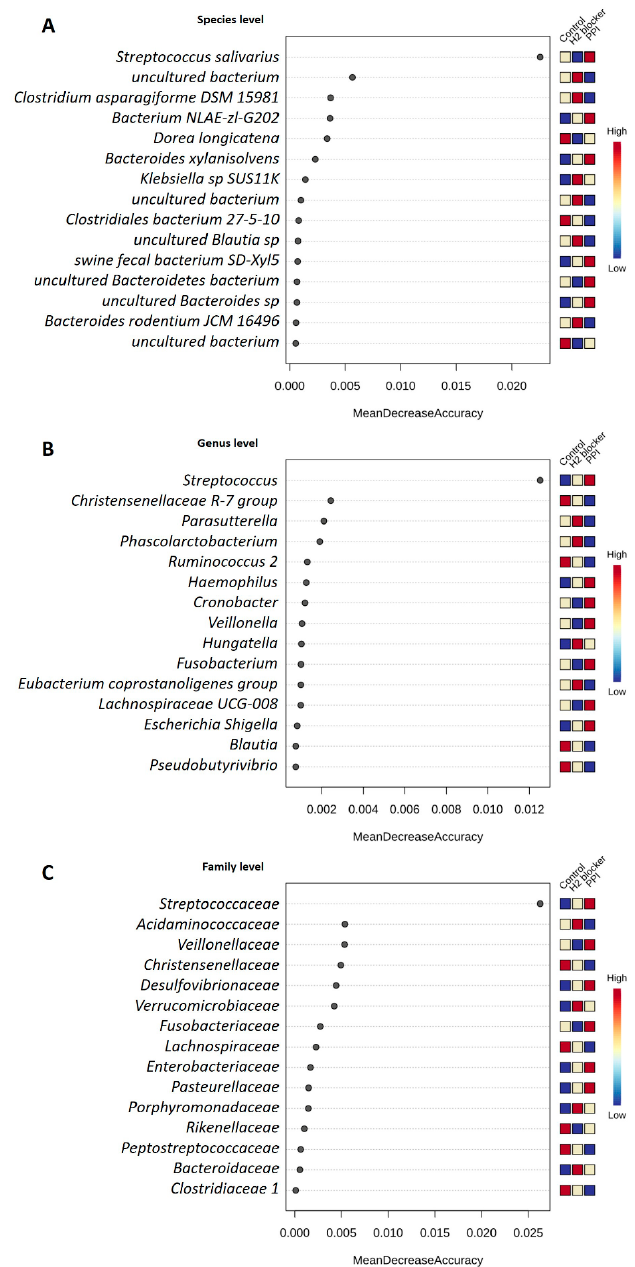
Figure 5. Determination of bacteria-specificity for discrimination across H 2 -blocker users, proton pump inhibitor users, and controls in hemodialysis patients. The anti-acid drugs discriminatory taxa were determined by applying random forest analysis using the ( A ) species-levels abundance; ( B ) genus-level abundance; and ( C ) family-level abundance.